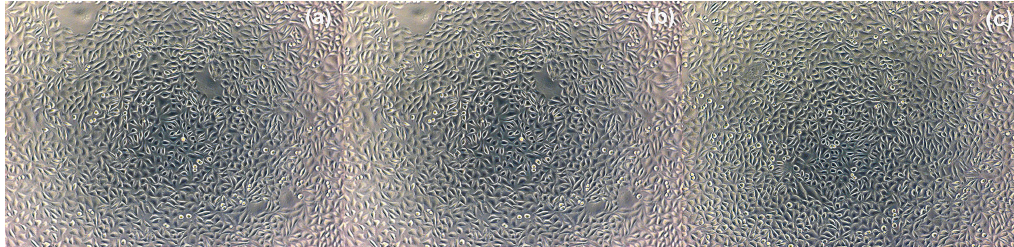
Figure 11. L929 cells in extract concentration 100% for NiTi (a), for NiTiCu (b) and negative control of L929 cells (c).